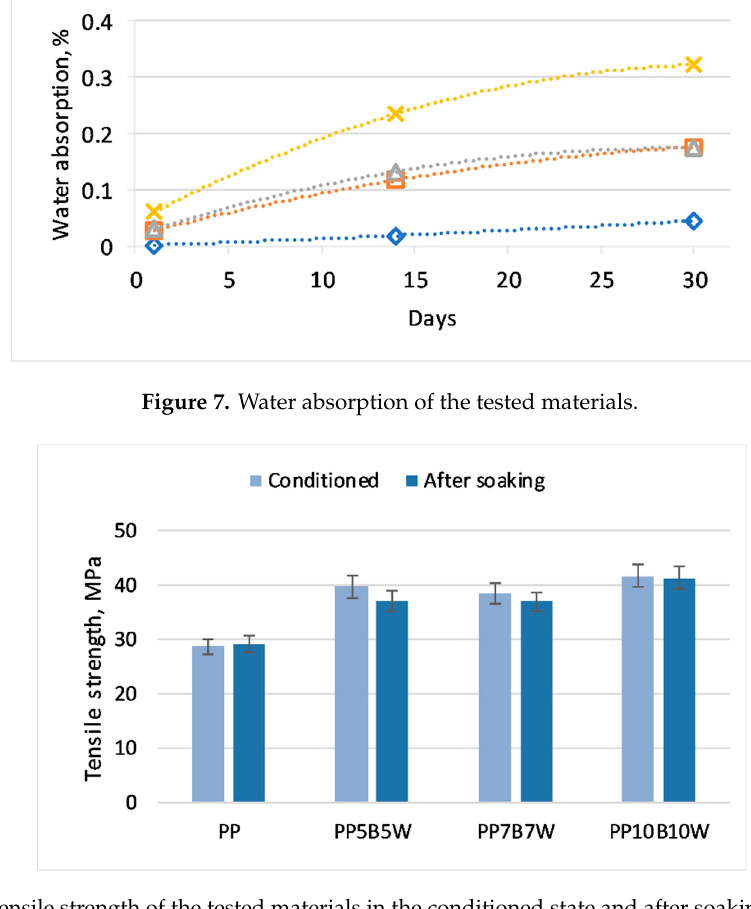
Figure 8. Tensile strength of the tested materials in the conditioned state and after soaking in water for 30 days.